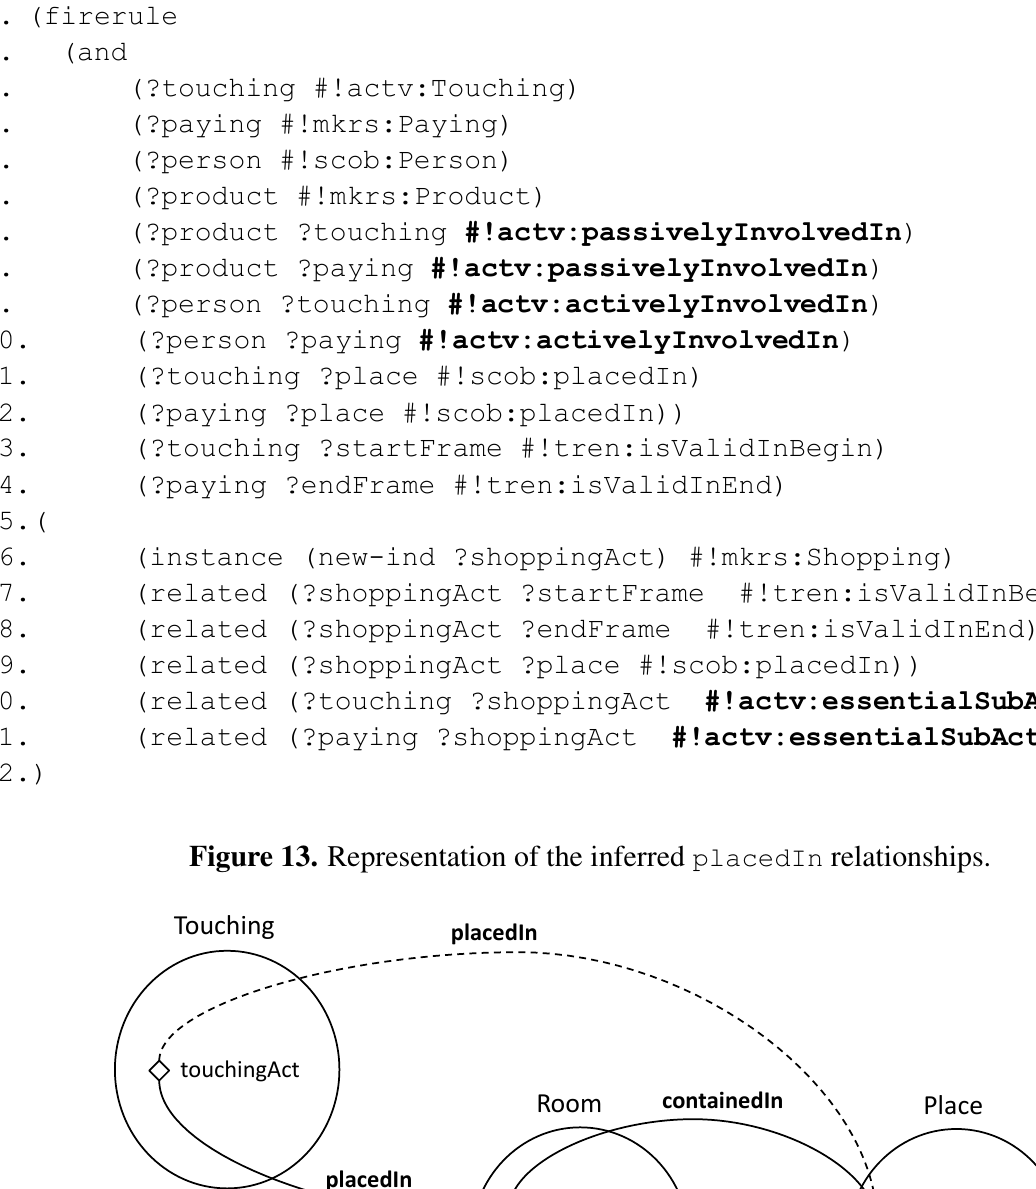
Figure 12. Simplified rule to recognize shopping.